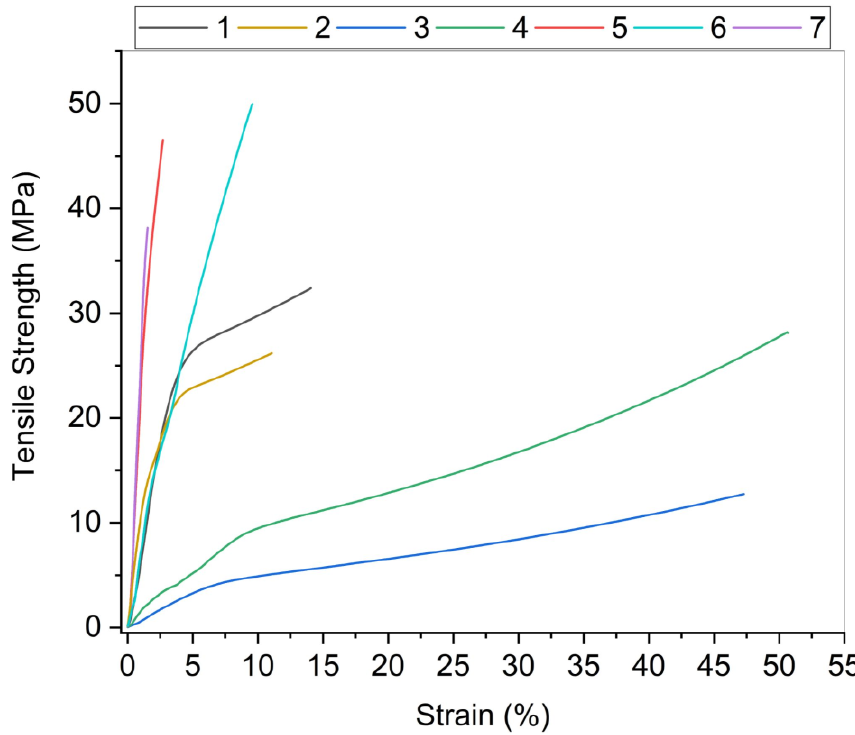
Figure 1. Tensile strength with the respective strain for nanocellulose, alginate, and chitosan nanocomposites. The composition of the films 1–7 are described in Table 1.